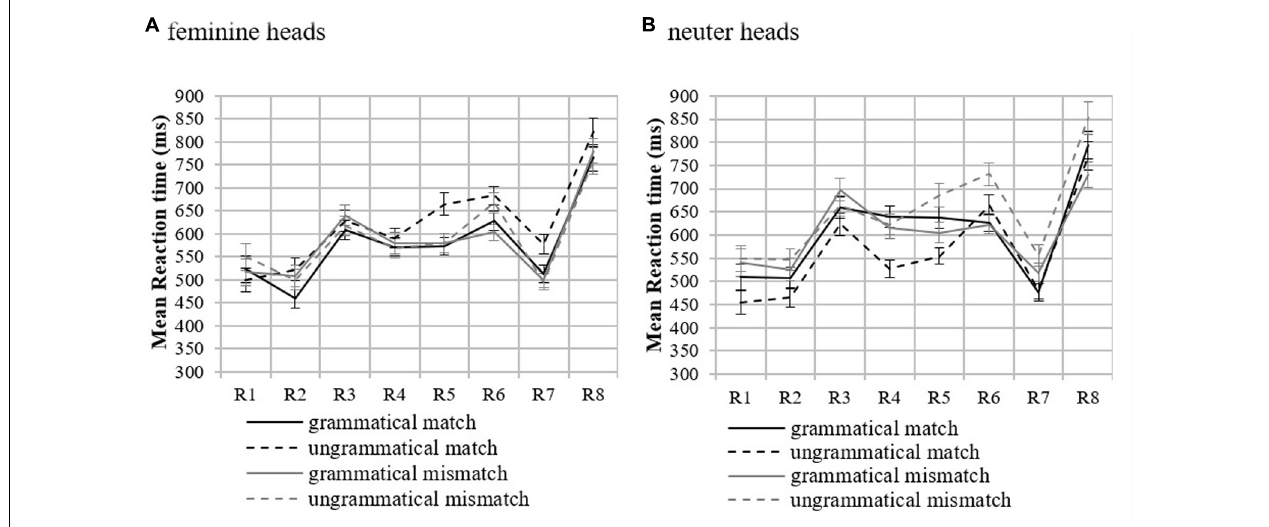
FIGURE 1 | Mean reaction times by condition in feminine (A) and neuter (B) heads in Experiment 1. Error bars indicate the standard error of the mean across participants. R on the x -axis stands for Region. Region 3 : Head, Region 4 : Attractor, Region 5 : Agreement target (adjectival predicate), Region 6 : first post-critical region, Region 7 : second post-critical region, and Region 8 : sentence-final region.